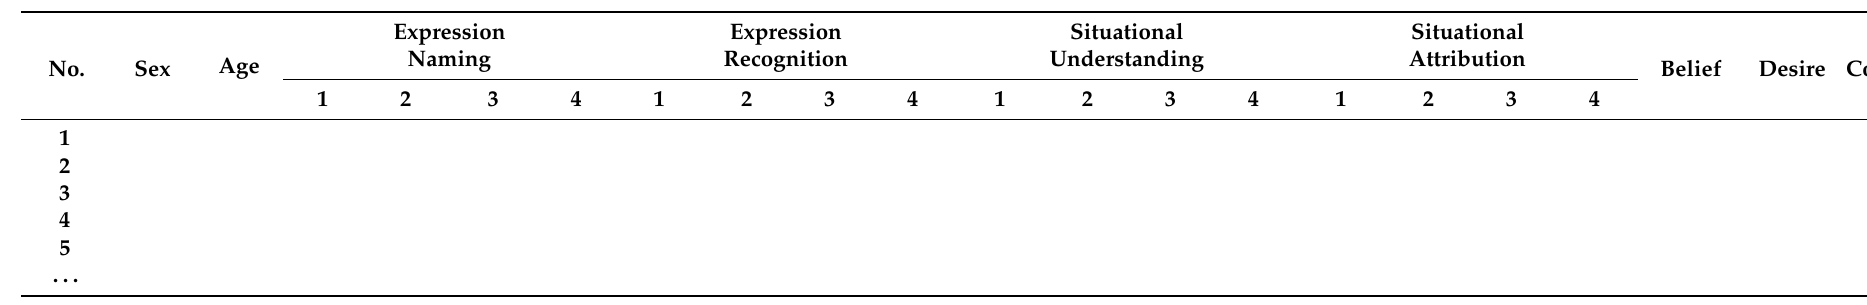
Table A1. Emotion understanding record sheet.